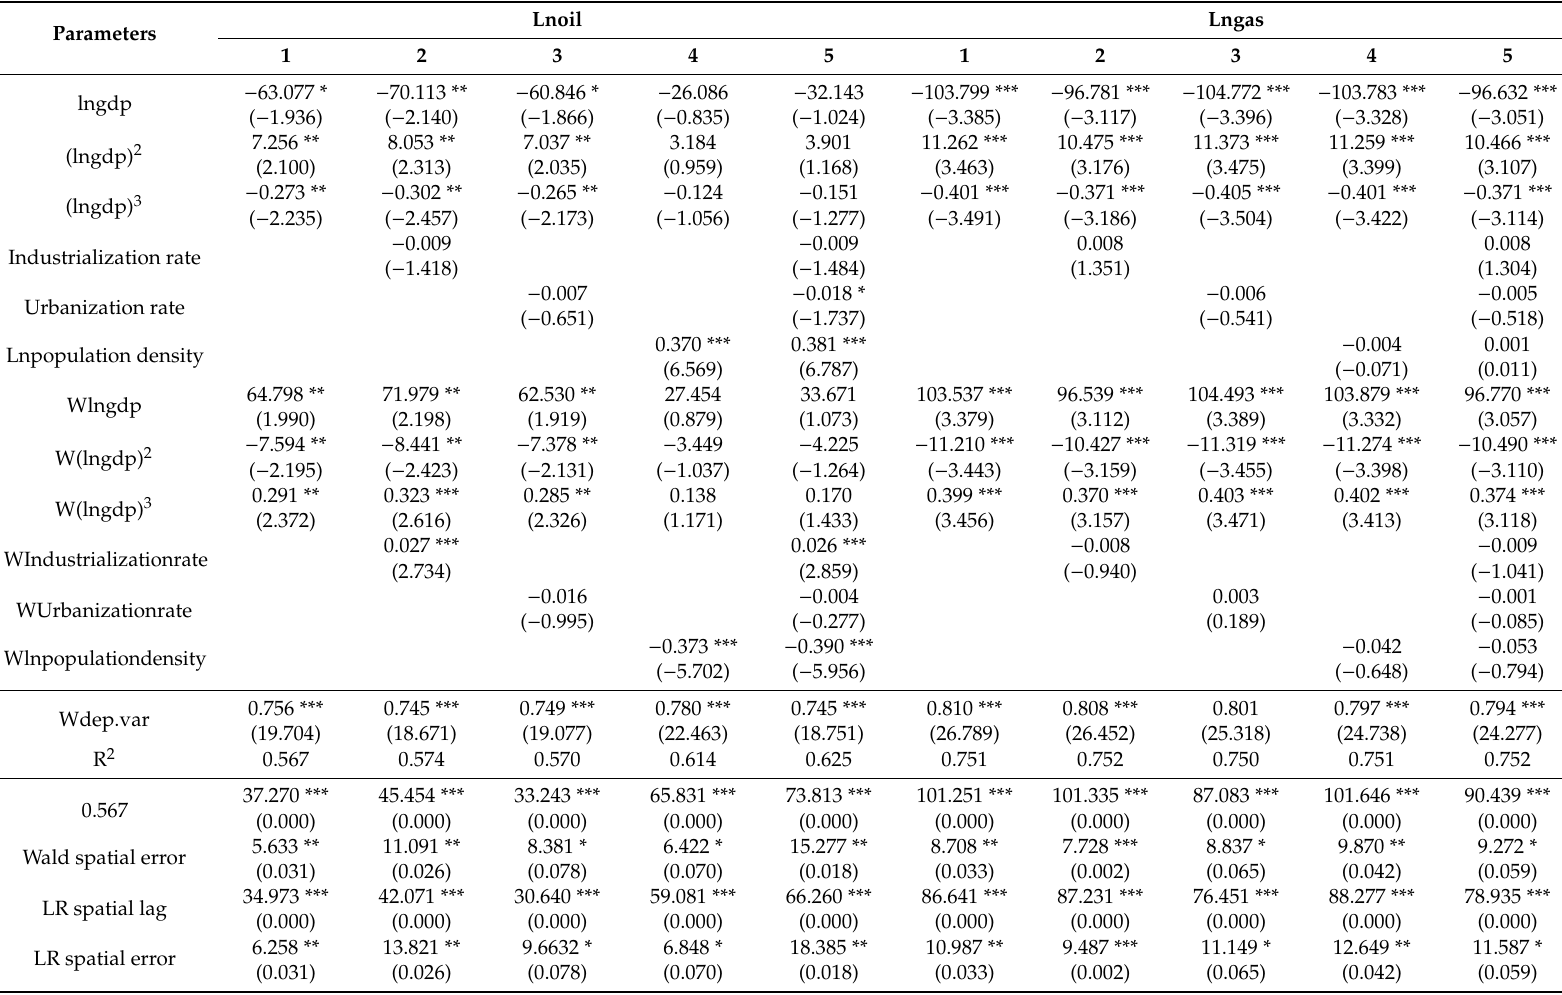
Table 9. Spatial Durbin model estimation results of mixed OLS e ff ect of total oil consumption and total gas